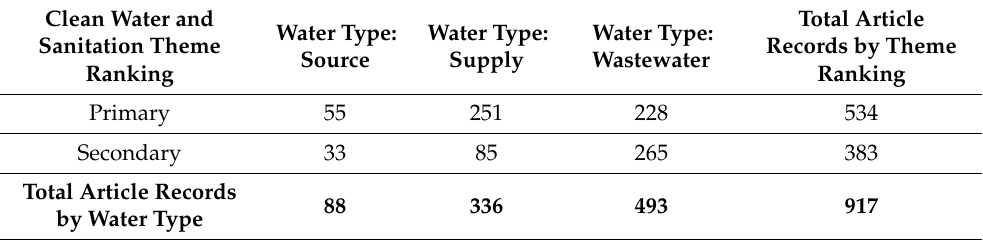
Table 8. Water type distribution within the water-related AMR article records by primary or secondary categorization of the clean water and sanitation theme ( n = 12,638).